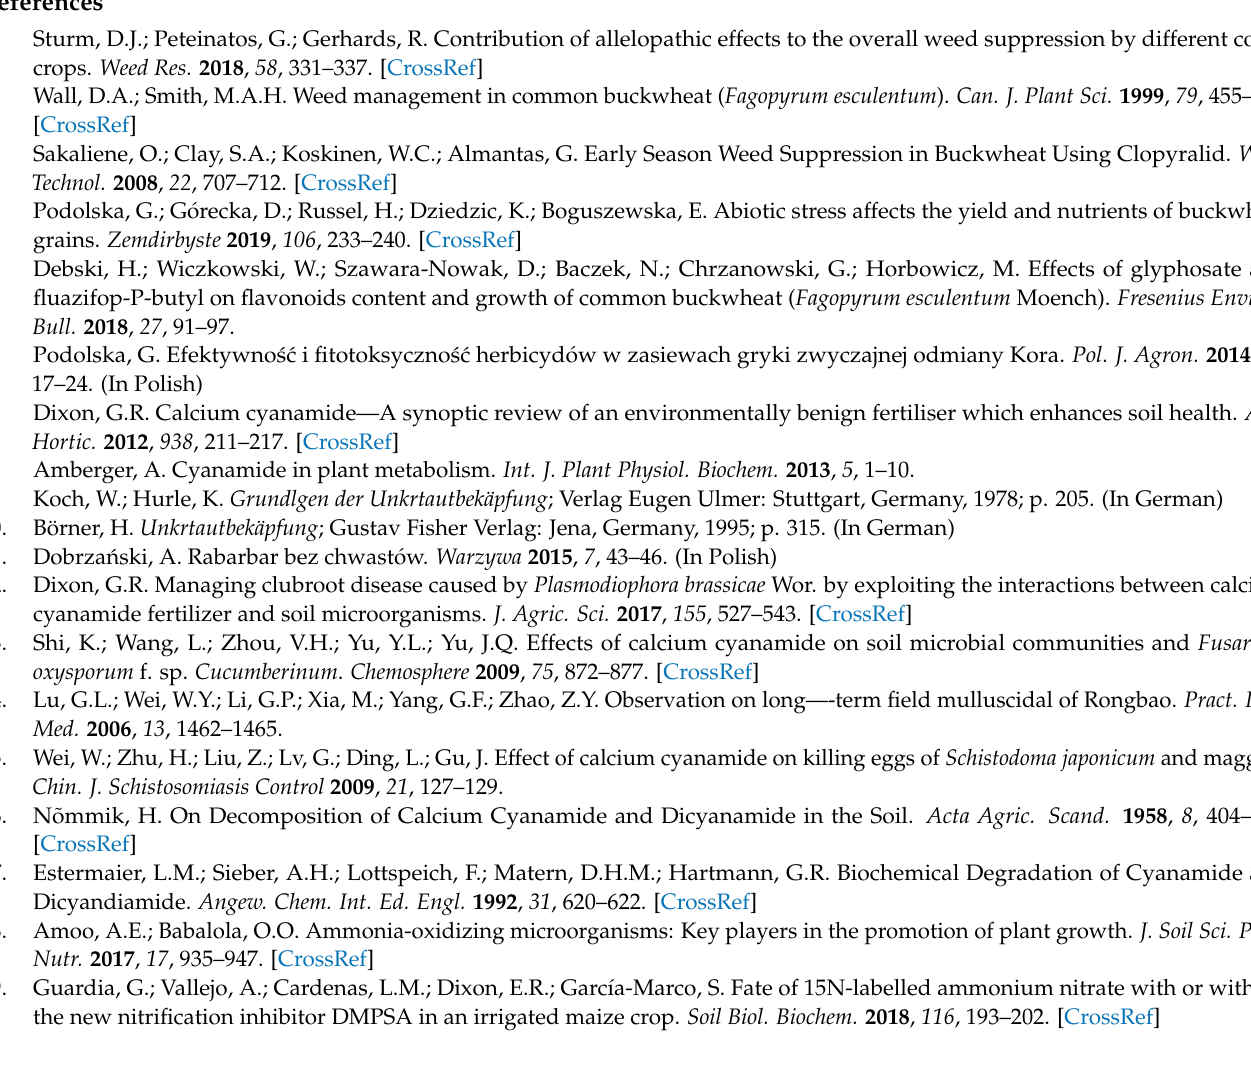
Figure A3. The experiment with the common buckwheat (BBCH 51).